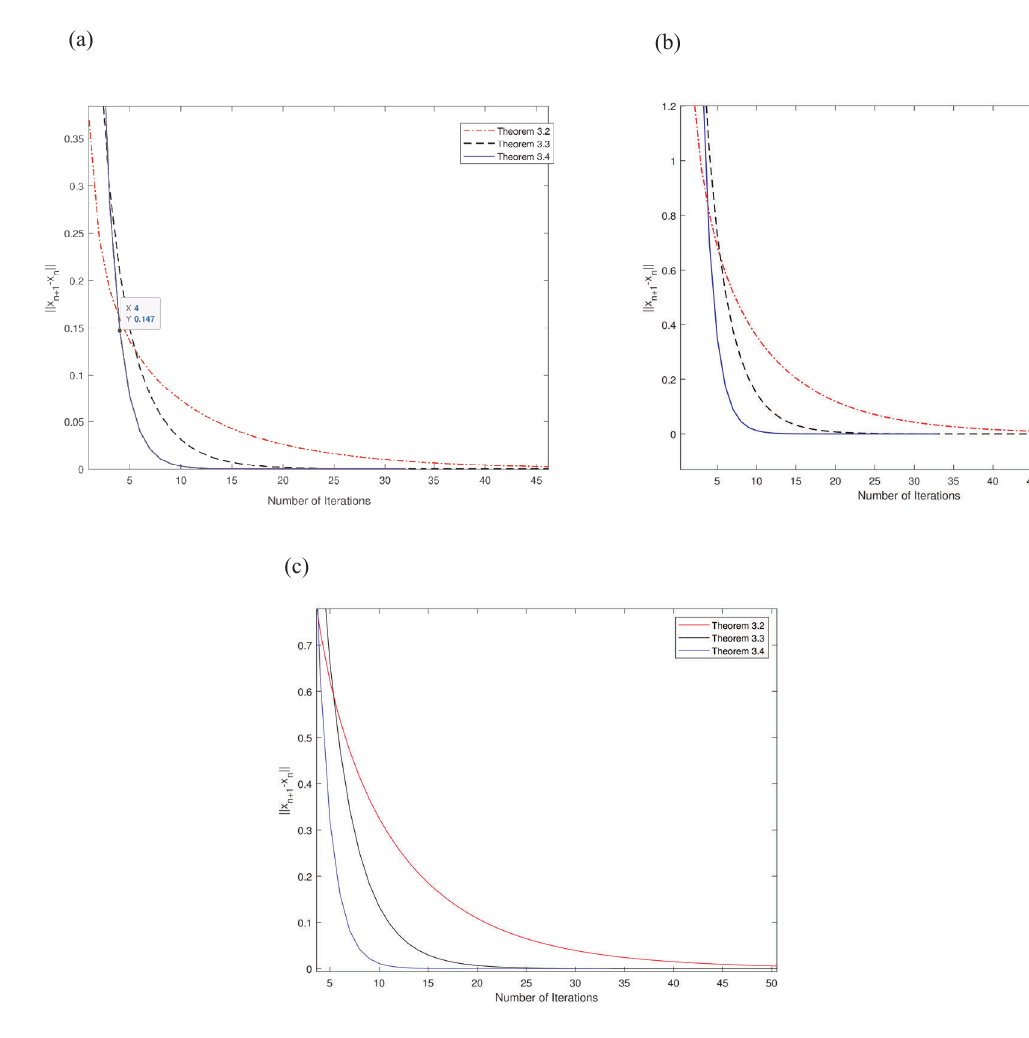
Fig. 1. Error plots for first (a), second (b) and third (c) choice.